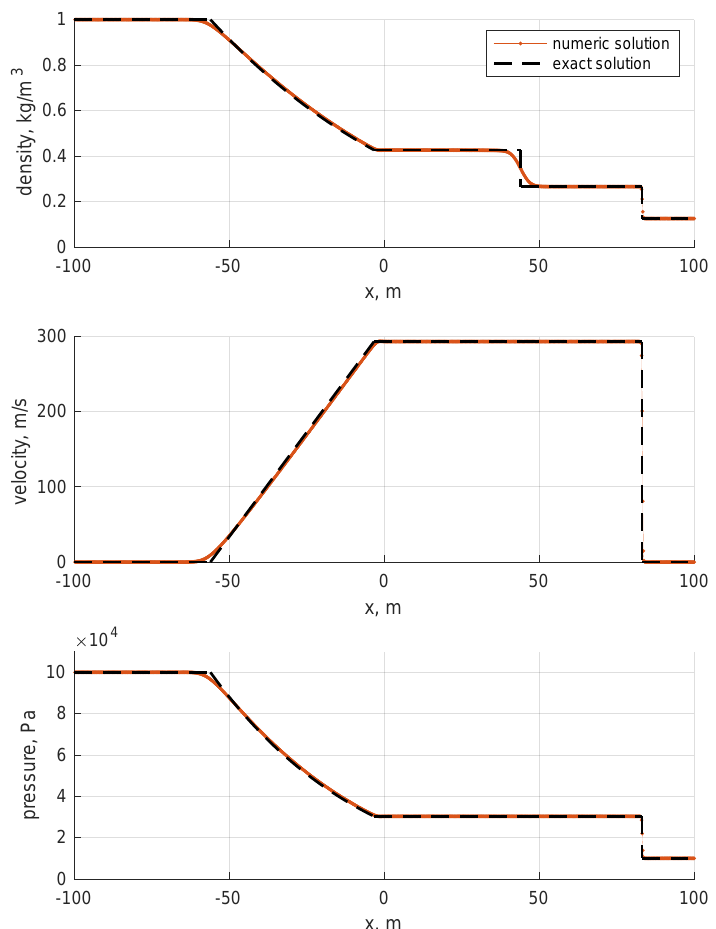
Figure 6. Sod problem. Single species: air. Ideal EoS. Initial conditions listed in Table 3. First order Godunov. One thousand